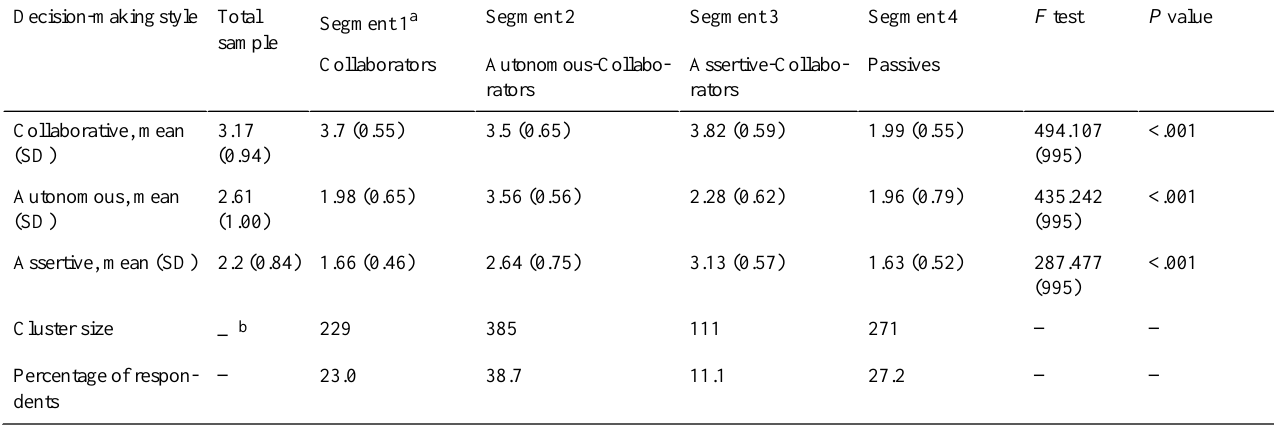
Table 4. Final cluster solution and analysis of